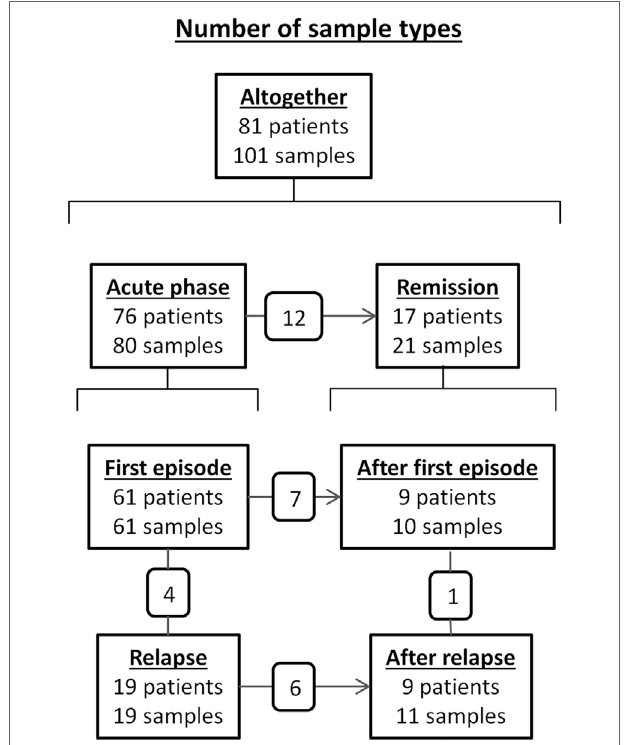
FigUre 2 | Number of patients and samples tested for anti-ADAMTS13 IgG subclass distribution according to disease stage. The number of common patients between disease stage groups are shown in the small boxes over the connecting